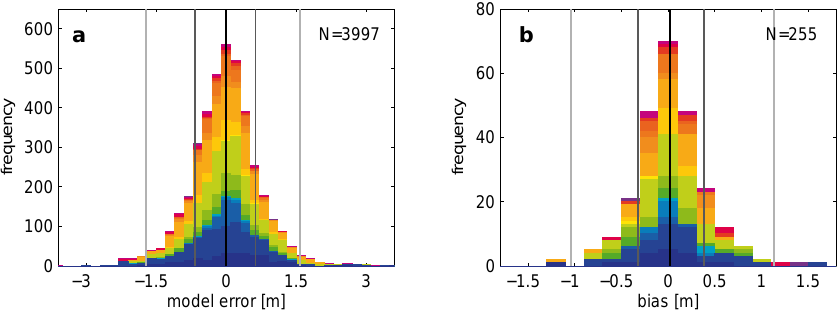
Fig. 9. Cross-validation results; (a) distribution of the errors of the modeled mass balances; (b) distribution of the model bias; vertical lines indicate the 2nd and 98th percentiles (light gray), 15th and 85th percentiles (dark gray), and median (black).